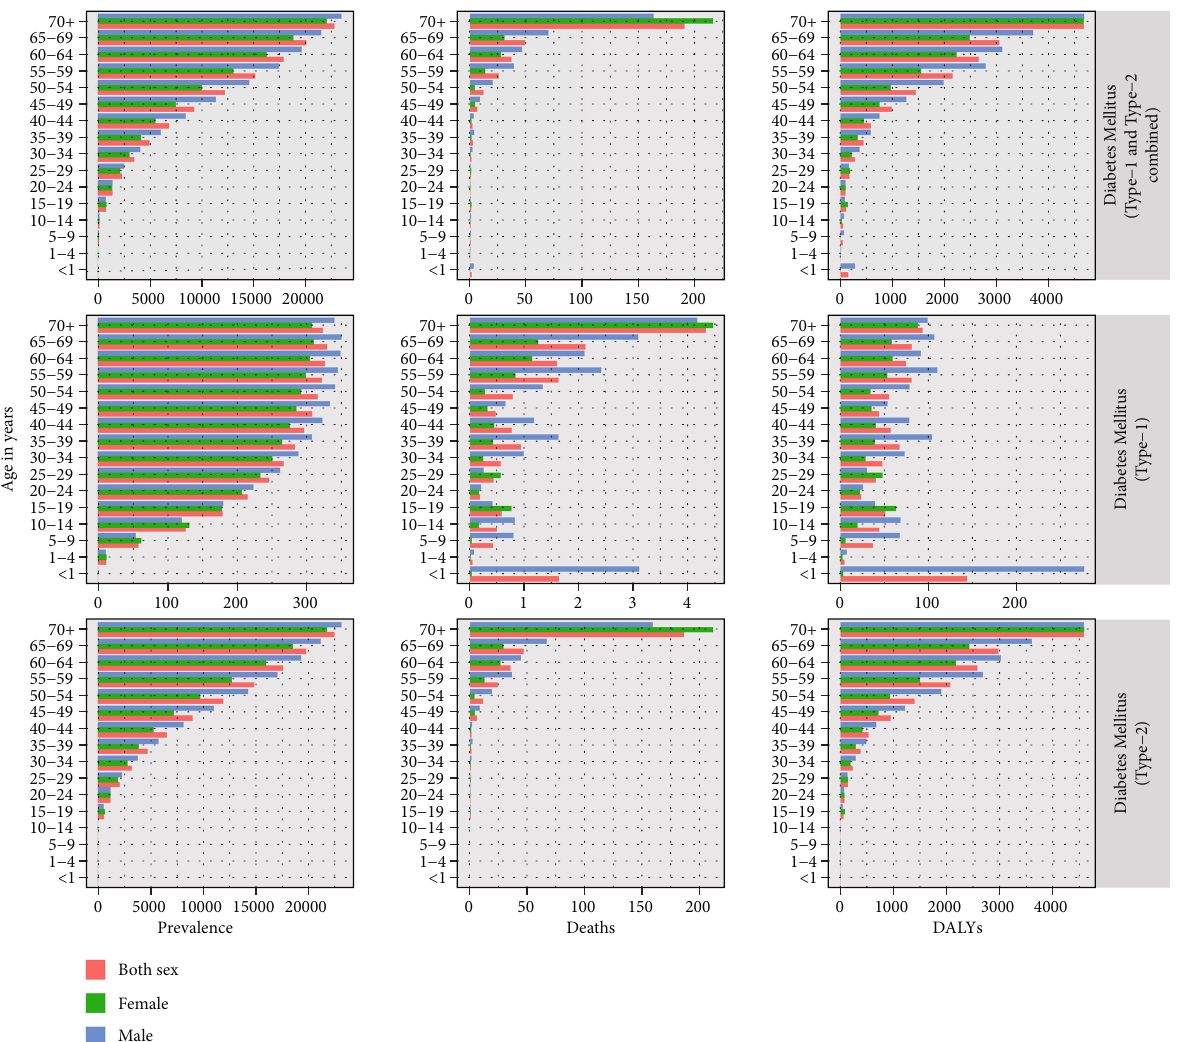
Figure 2: Age and sex distribution of the prevalance, mortality, and DALYs of